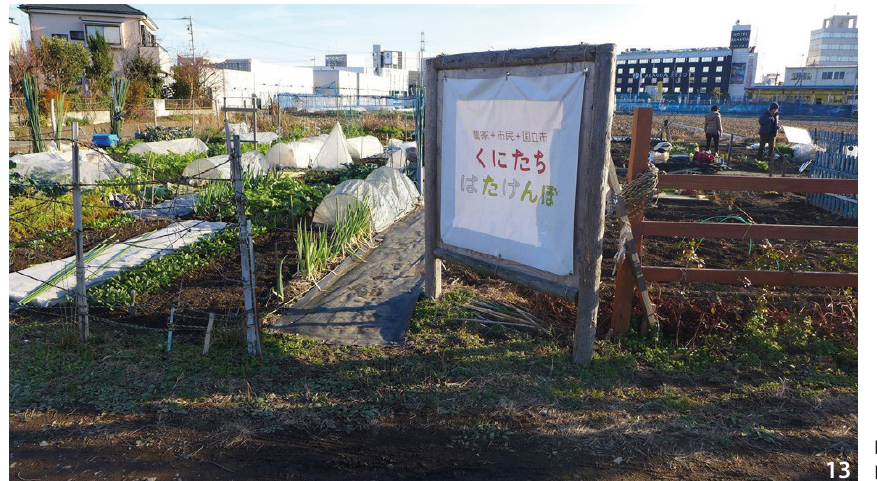
Figure 13 Urban agricultural activity in 13 Kunitachi (Source: the